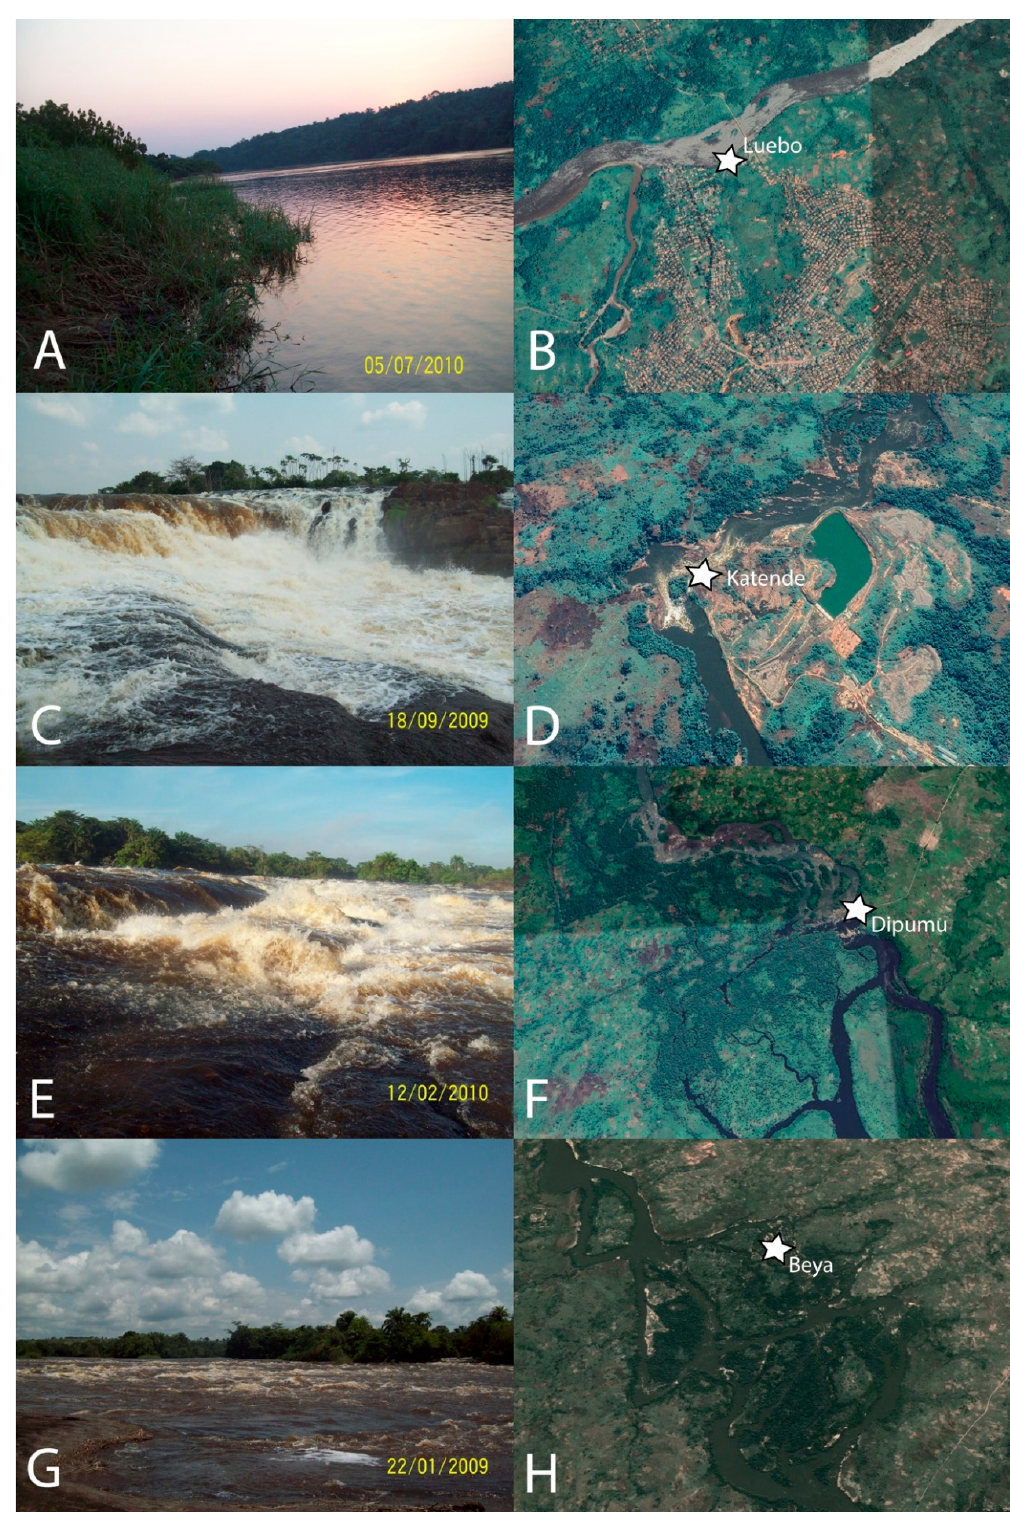
Figure A1. Google Earth projections and biotopes of the collection sites located along the main channel of the LR: ( A , B ) Luebo (Site 1); ( C , D ) Katende (Site 8); ( E , F ) Dipumu (Site 5); ( G , H ) Beya (Site 2).